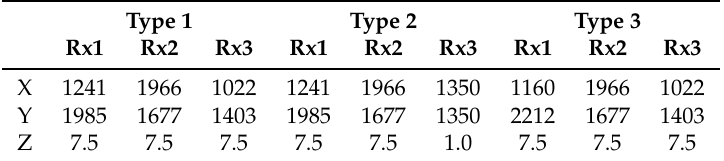
Table 2. The sensor locations in terms of the three types of sensor placement in unit of meters. Type